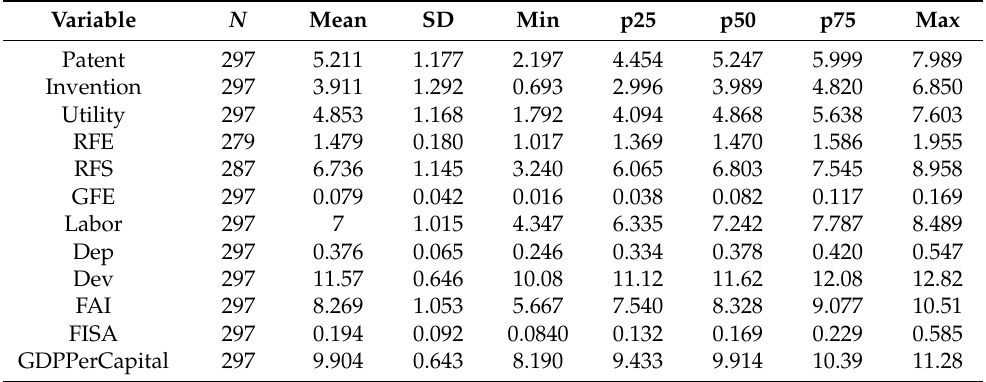
Table 2. Descriptive Statistics (The sample size in descriptive statistics is the sample participating in the main